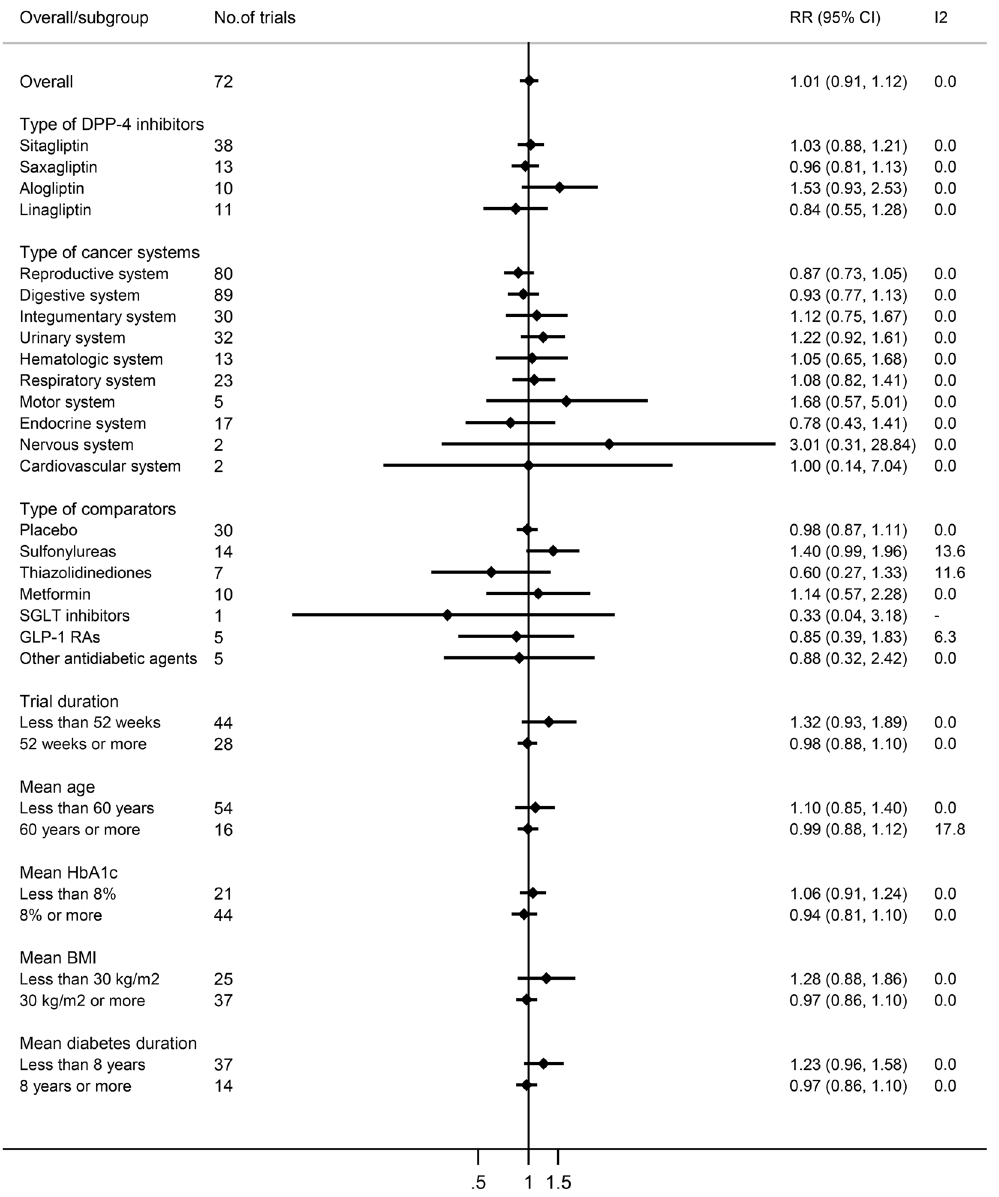
Figure 3. Overall and subgroup meta-analysis of DPP-4 inhibitors on risk of